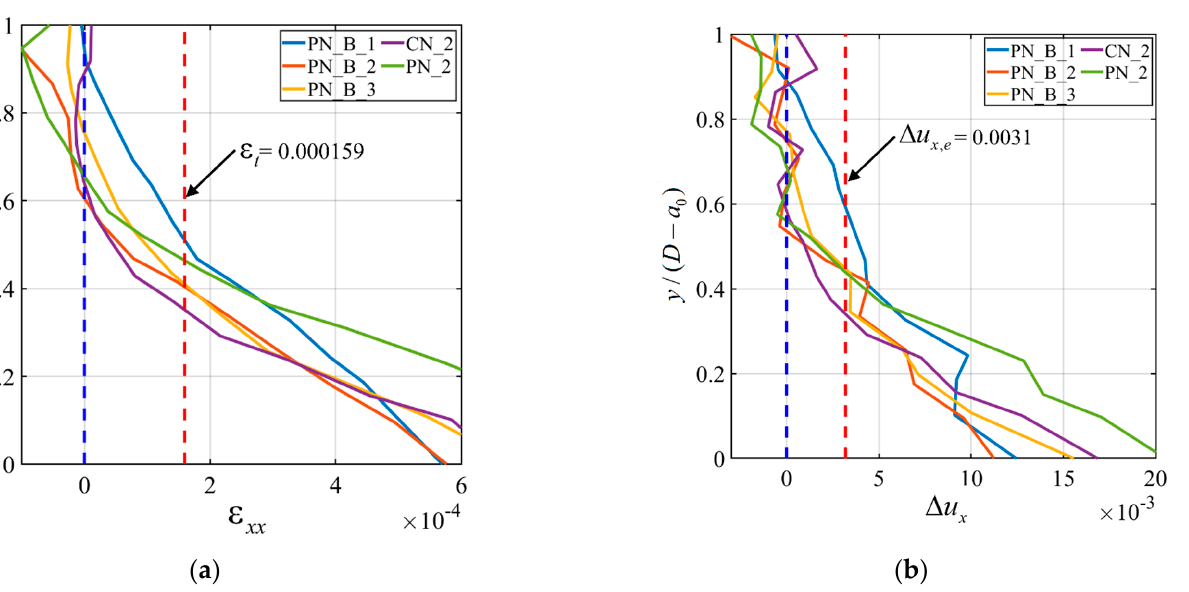
Figure 12. ε xx and Δ u x profiles for CN_2: ( a ) Loading points shown in colored circle for ε xx and Δ u x ; ( b ) ε xx profile; and ( c ) Δ u x profile.